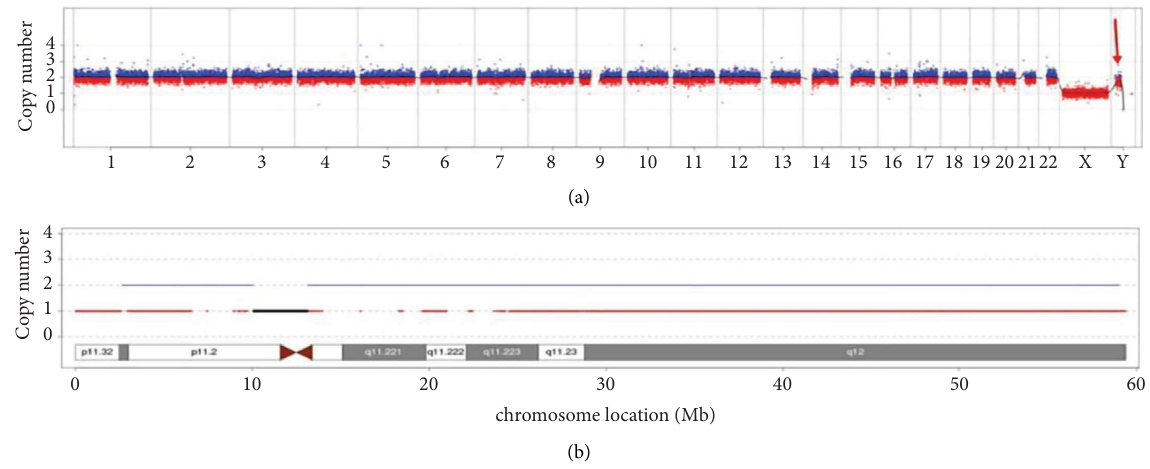
Figure 2: CNV-seq result: an approximately 59.37Mb duplicated fragment in chrY: 1–59373566; in (b), the blue line represents the ratio curve and two copy numbers, corresponding to the left ordinate; the red line represents highly repetitive areas; the black line represents the region of the centromere. (a) Whole genome sequencing results. (b) chrY: